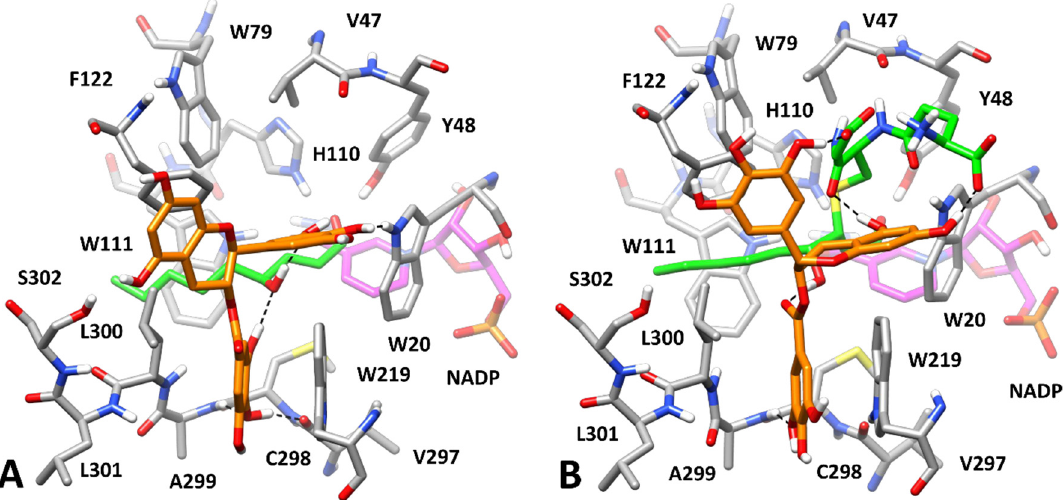
Figure 10. Minimized average structure of AKR1B1 bound to HNE and GSHNE, in complex with GCG. Panel ( A , B ) refer to HNE and GSHNE, respectively. GCG is shown in orange, the portion of the cofactor adjacent to the ligand binding site is shown in magenta, and the substrates are shown in green. Relevant protein residues (shown in grey) are indicated. Ligand–protein and ligand–substrate H-bonds are shown as black dashed lines.